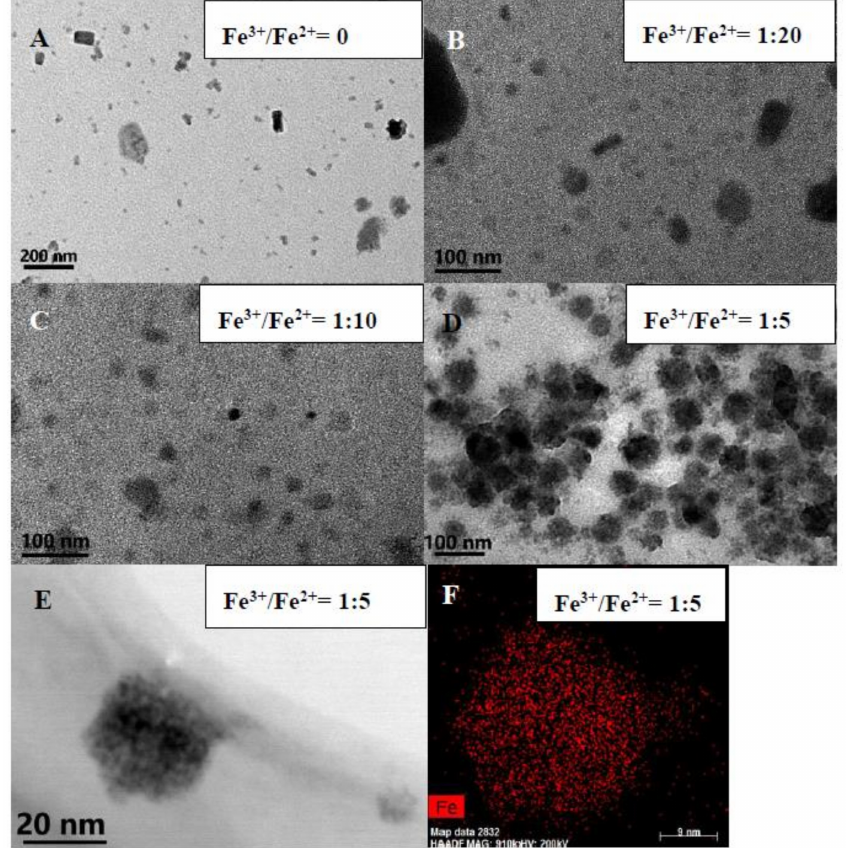
Figure 2. TEM images of samples prepared from PB containing capsules with different amount of added Fe 3+ . The amounts of added Fe 3+ with respect to the Fe 2+ are indicated in the images; Figure 2 ( A – D ) at lower magnification, ( E ) at higher magnification, and ( F ) EDX mapping of iron